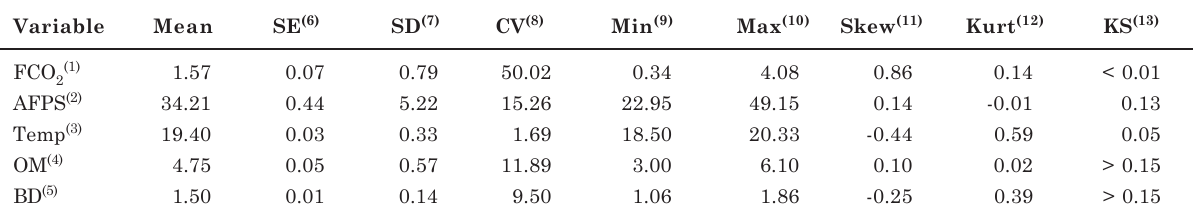
n=141; (1) Soil CO emission ( μ mol m -2 s -1 ); (2) Air-filled pore space (%); (3) Soil temperature (ºC); (4) Organic matter content (g dm -3 ); 2 (5) Bulk density (g cm -3 ); (6) Standard error of the mean; (7) Standard deviation; (8) Coefficient of variation; (9) Minimum; (10) Maximum; (11) Skewness; (12) Kurtosis; (13) p-value of Kolmogorov-Smirnov normality test.